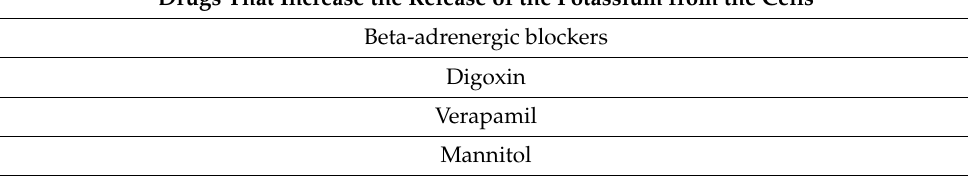
Table 4. Drugs that increase the serum potassium level. Drugs That Increase the Release of the Potassium from the